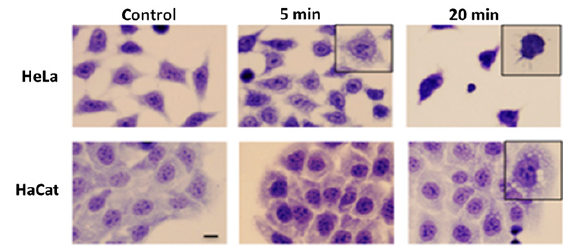
Figure 35 - Morphological changes induced by chlorin 42d on HaCaT and HeLa cell lines after being incubated for 4 h with a concentration of 1.0 x 10 -7 M and subject to different irradiation times. After 24 h of light exposure, cells were fixed in cold methanol and stained with toluidine blue. Photographs are representative images of three different experiments for al. 2015 with permission of The Royal Society of